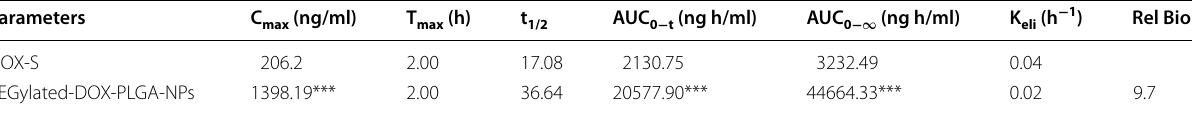
Table 4 Pharmacokinetic parameters of DOX after single oral dose of DOX-S and PEGylated-DOX-PLGA-NPs (mean